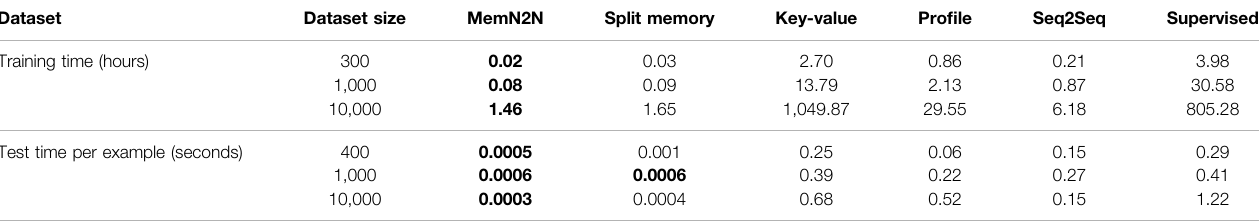
TABLE 1 | Training and test times of the models for the task 8 of the Personalised Barista Dataset. The test time per example is calculated by dividing the executing time for the task by the number of utterances in each dataset. The MemN2N and Split Memory models have the lowest time complexity. Dataset